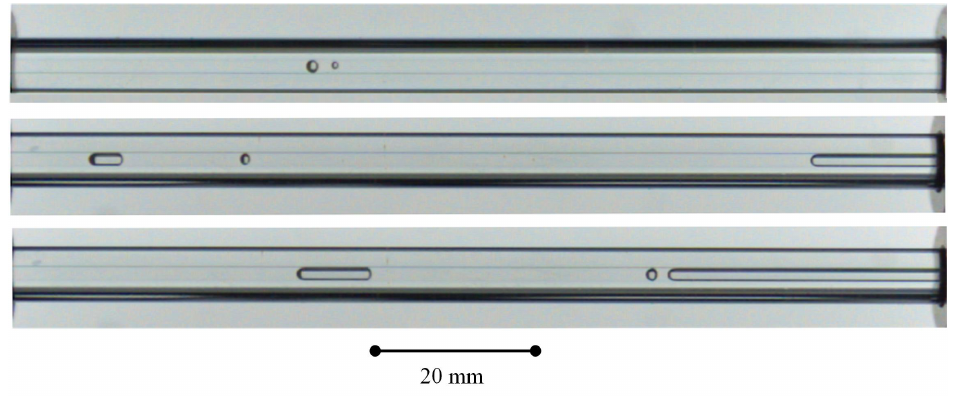
Figure 6. Examples of lens-shaped fluid structures captured in the adiabatic section for the 100 W input power and ethanol as working fluid—52.6% filling ratio